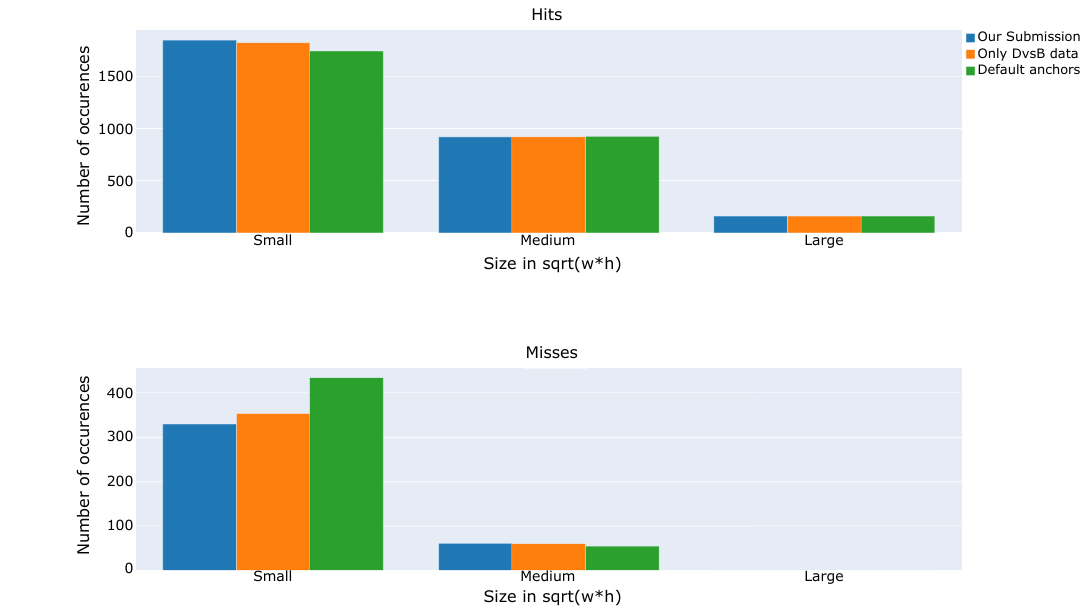
Figure 11. Hits and misses for different bounding box